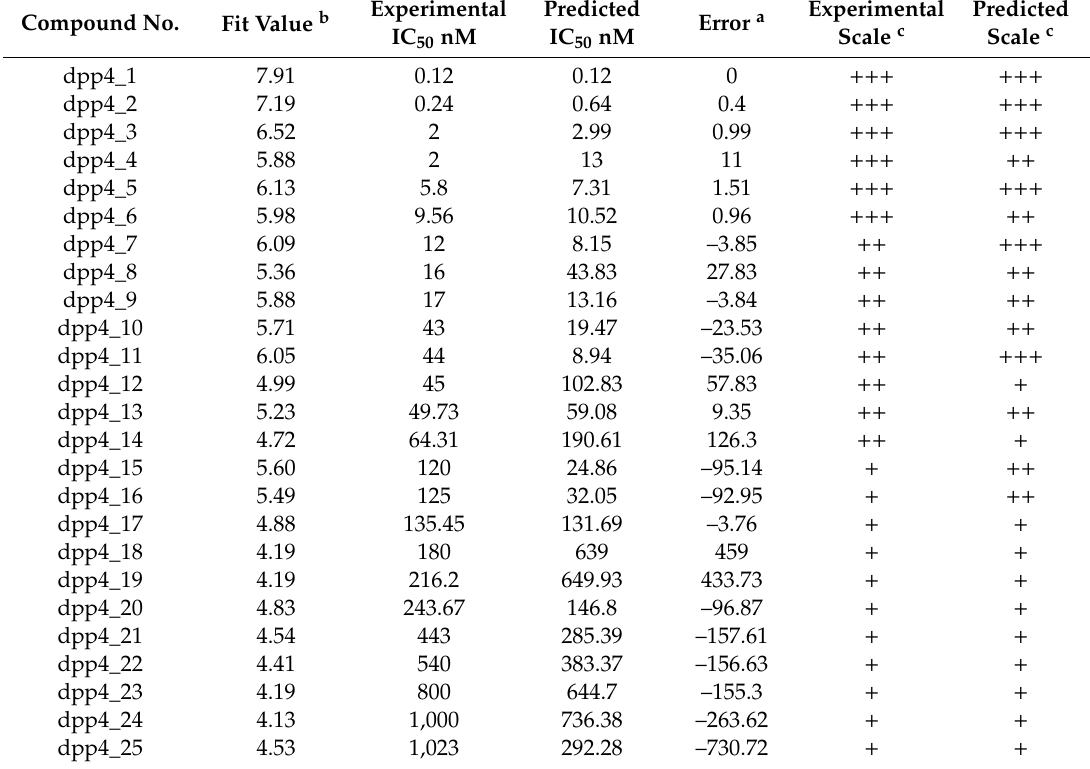
Table 1. The experimental DPP-IV inhibitory activities and predicted activities obtained by the HypoGen program on the basis of the pharmacophore model Hypo1 (training set). Compound No.